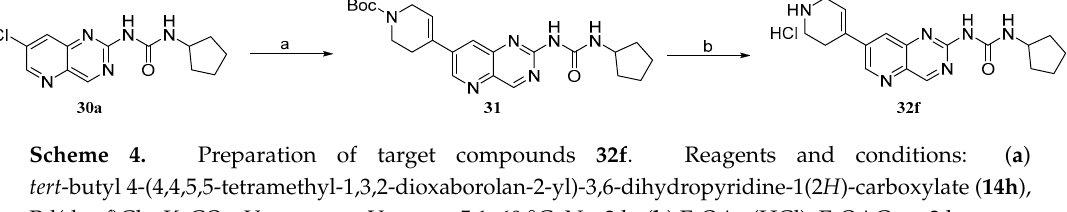
Scheme 4. Preparation of target compounds 32f . Reagents and conditions: ( a ) tert -butyl 4-(4,4,5,5-